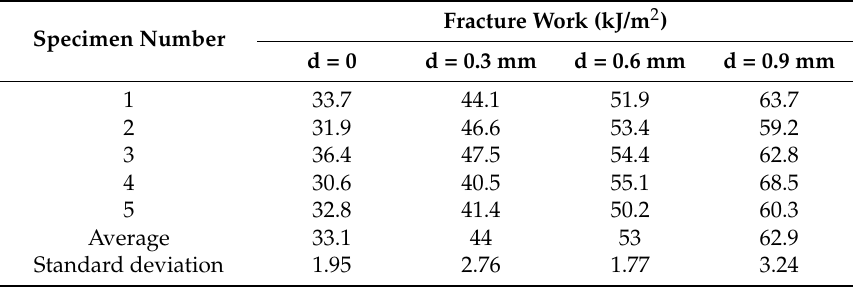
Table 7. Fracture work of unpinned Cf/Al composites and z-pinned Cf/Al composites using stainless steel pins with a volume fraction of 1% measured/determined by short-beam shear test.